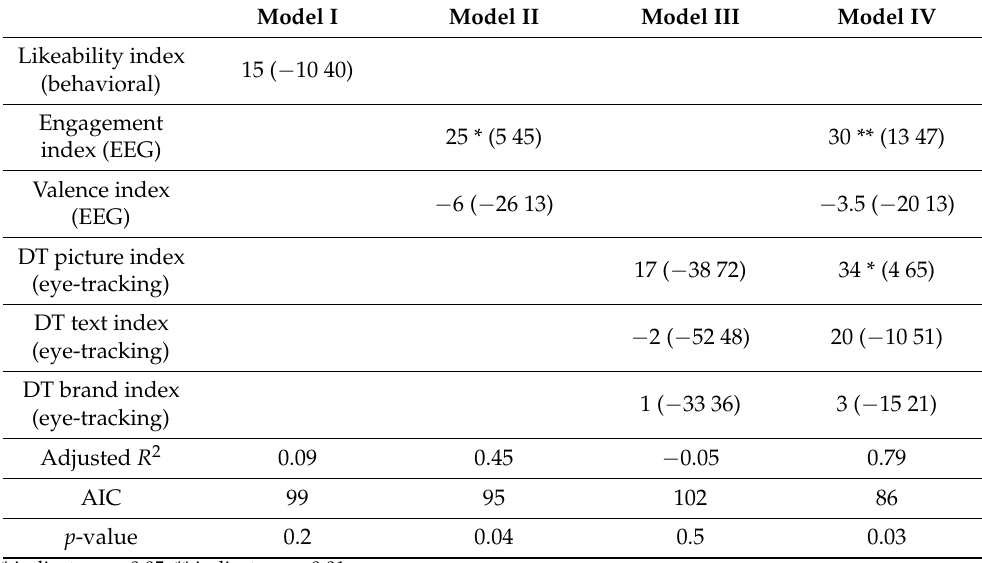
* indicates p < 0.05, ** indicates p < 0.01.